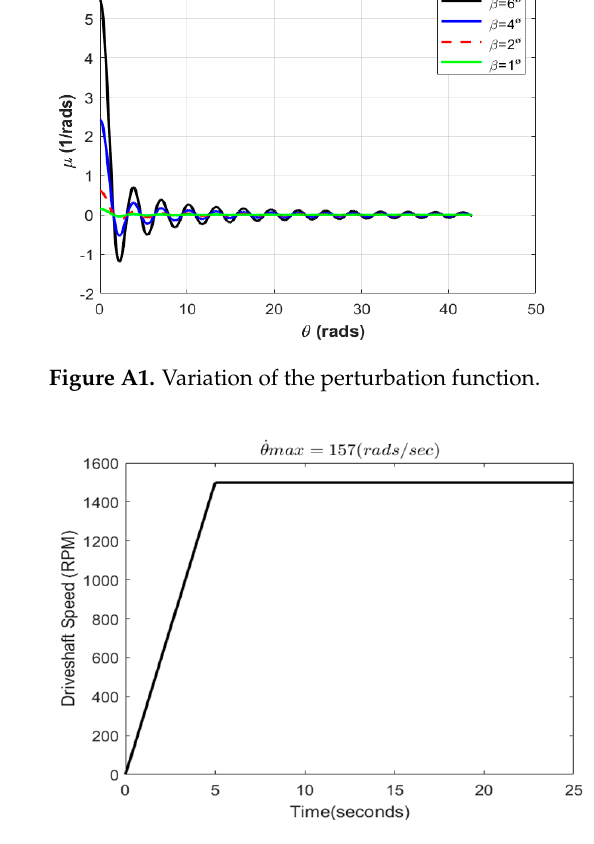
Figure A2. Driveshaft speed profile at maximum speed.